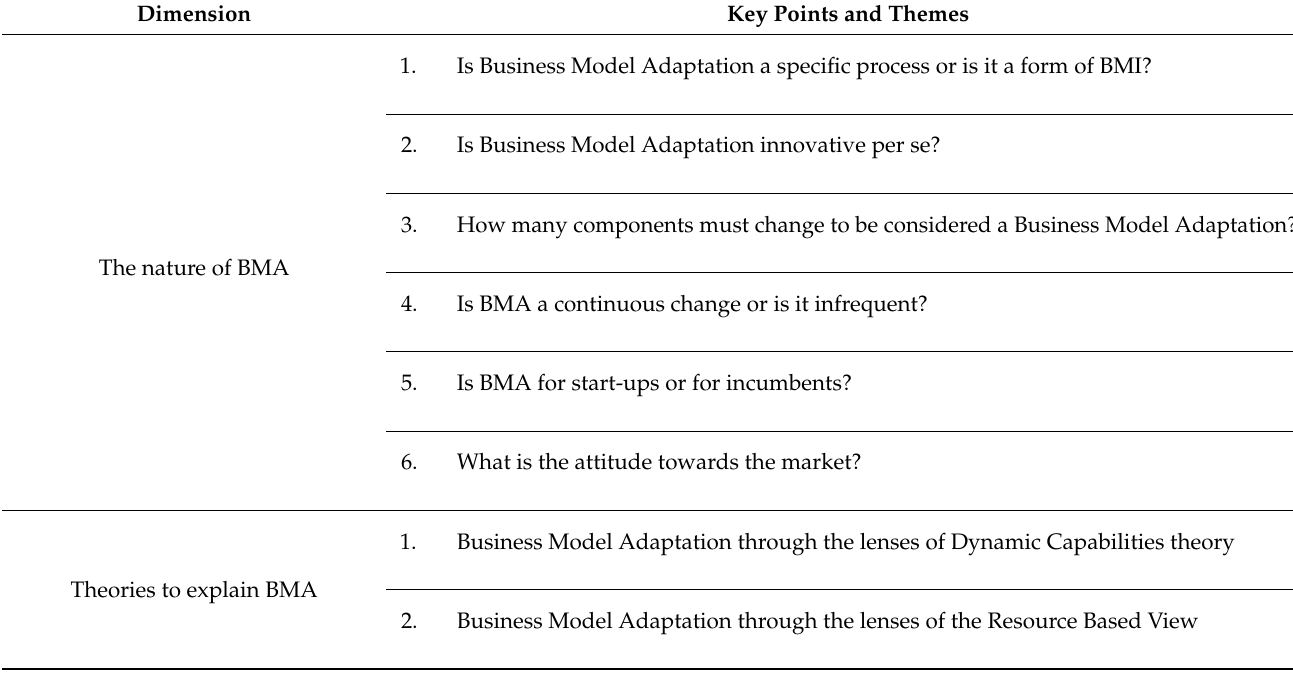
Table 3. Key points and themes that emerged from the coding strategy. Dimension Key Points and